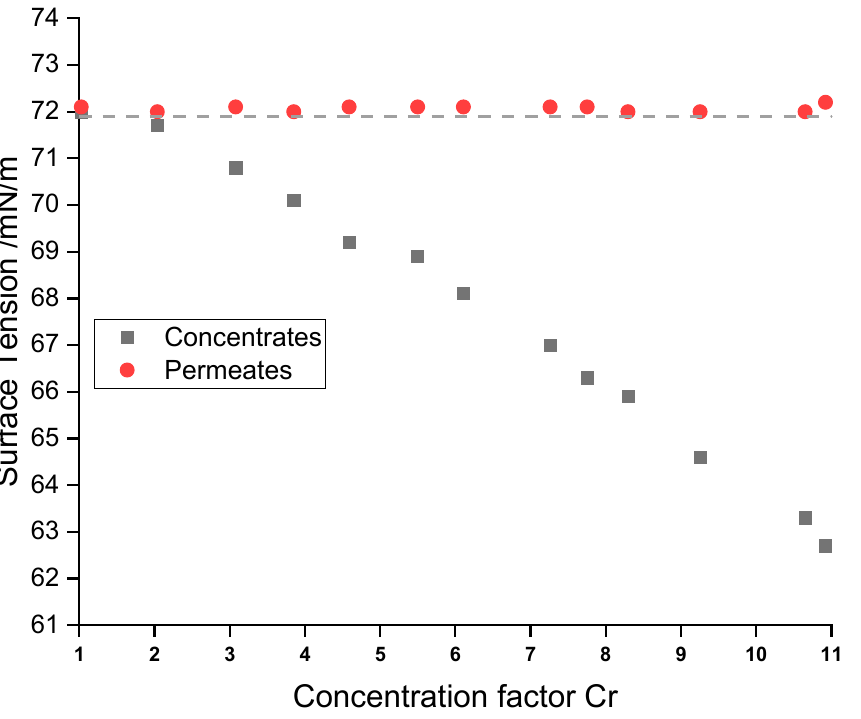
Figure 5. Surface tension of the RO permeates and concentrates with increasing concentration factor (cf) of chromium. The dashed line marks the surface tension of pure water at 25 °C.